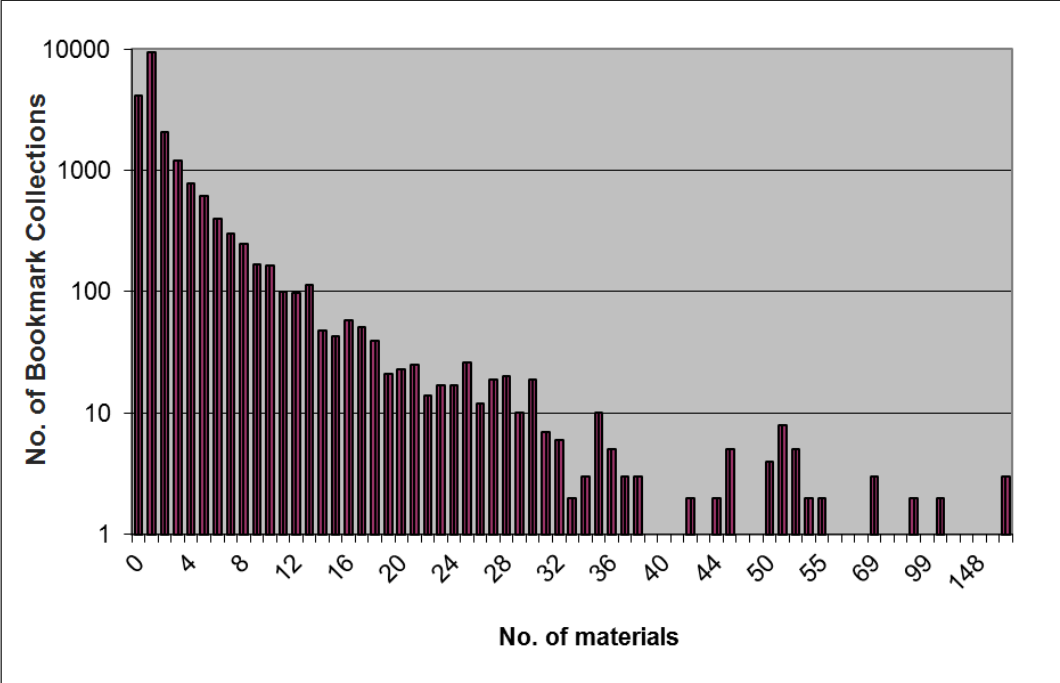
Figure 4. No. of materials in Personal